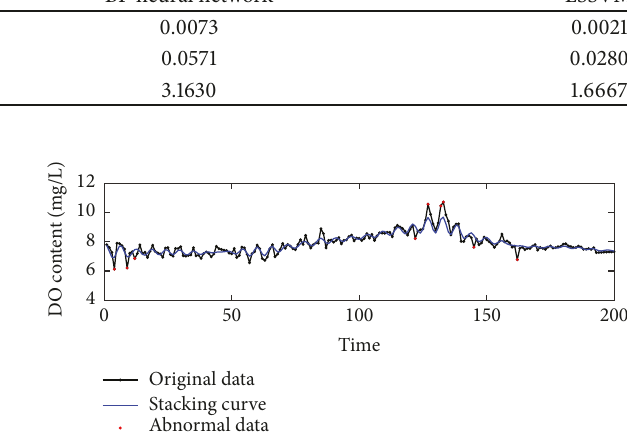
Figure 21: Outlier detection results for DO monitoring value.